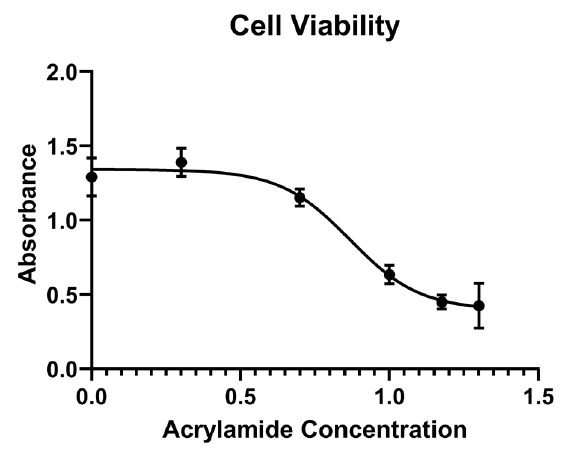
Figure 1. The MTT results of the acrylamide